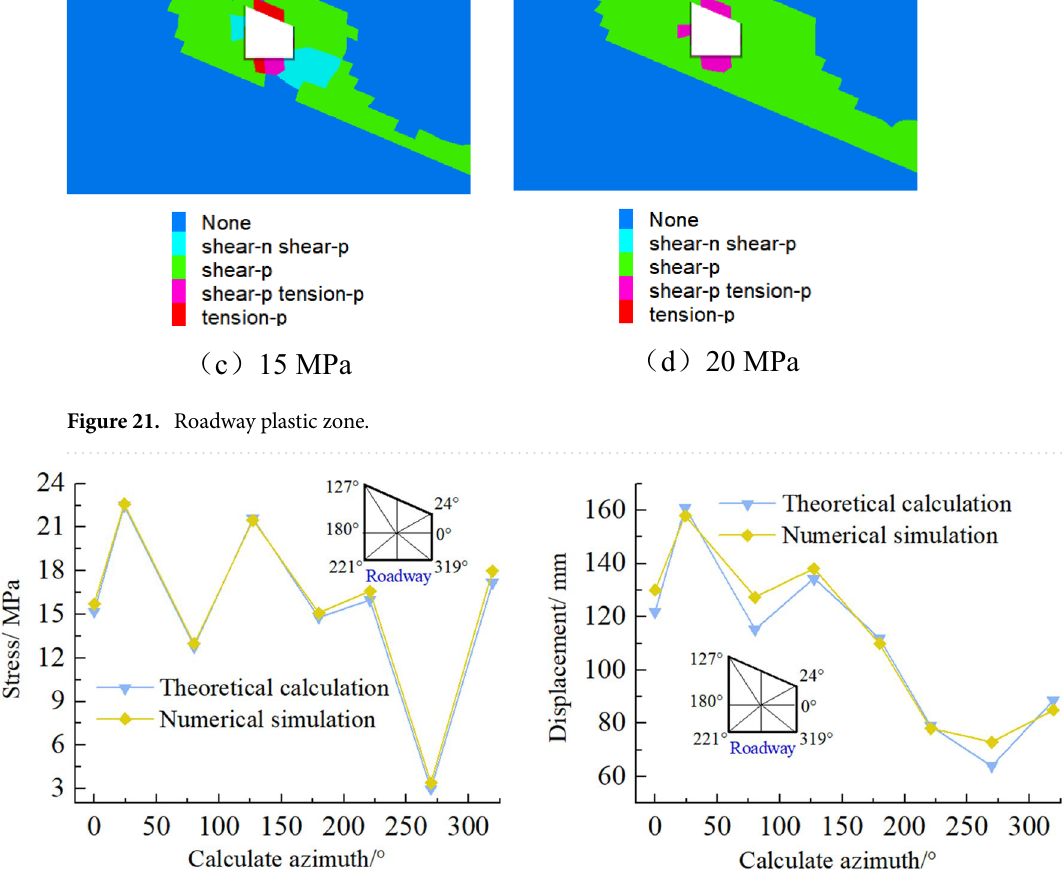
Figure 22. Comparison between theoretical calculation and numerical simulation